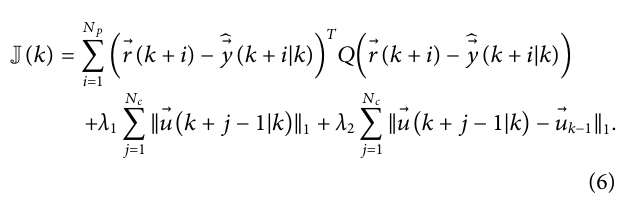
Frontiers in Physiology |